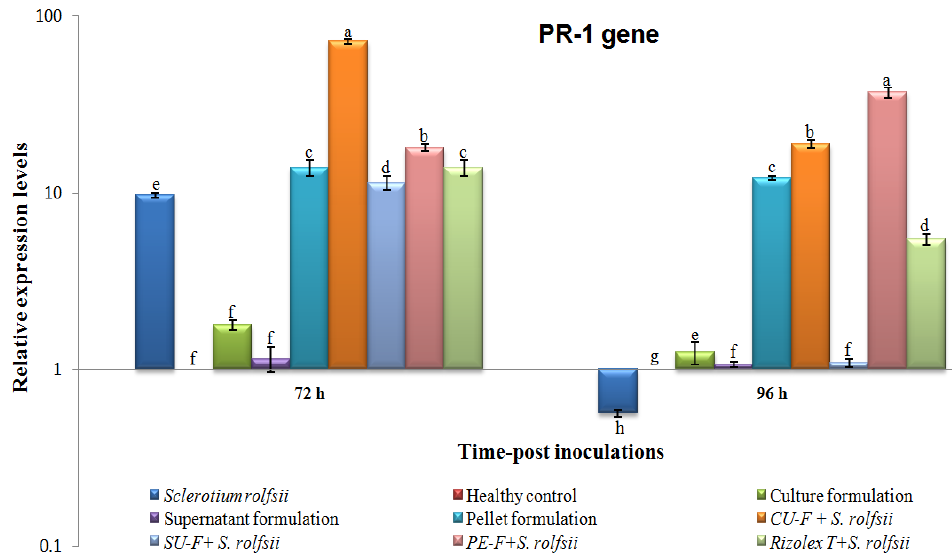
Figure 10. Relative expression levels of PR-1 gene in peanut plants at 72 and 96 hpi of talc-based culture, supernatant, and pellet formulations of Streptomyces cellulosae Actino 48 in a soil infected with Sclerotium rolfsii . Compared to the healthy control, the relative expression levels higher than 1 indicate an increase in gene expression (upregulation), while values lower than 1 indicate a decrease in expression levels (downregulation).